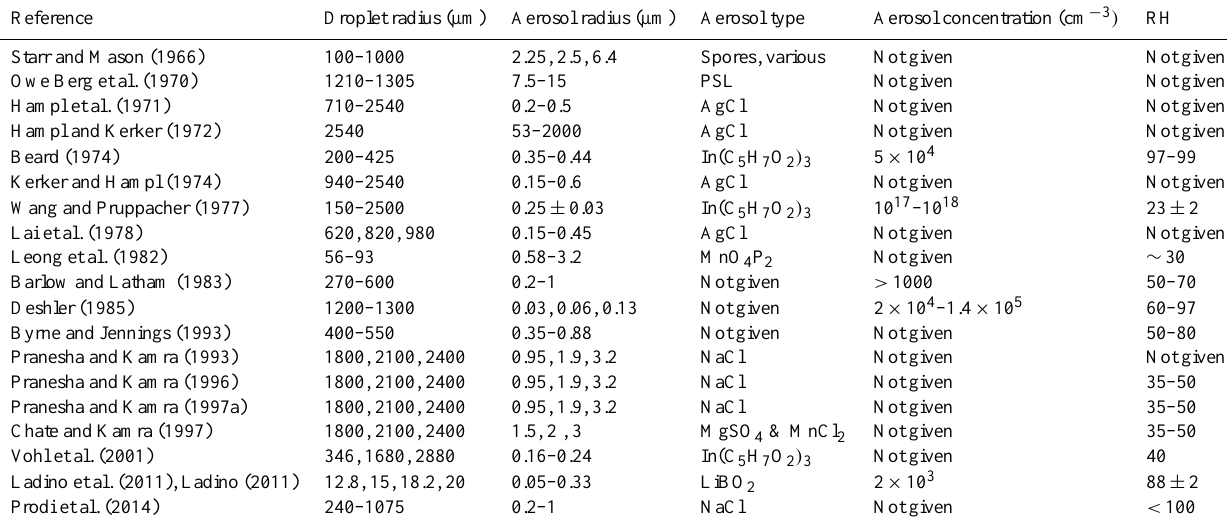
Table 1. Experimental results from previous studies of CE.